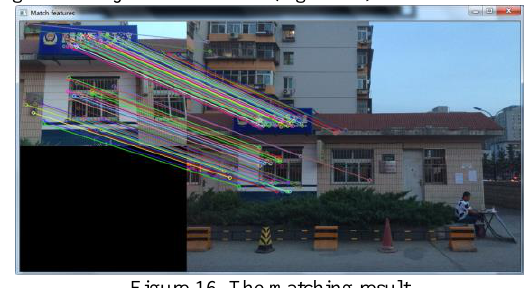
Figure 15. The functional modules of the system The matching result between the local image and the global image of an object is as follows (Figure 16).